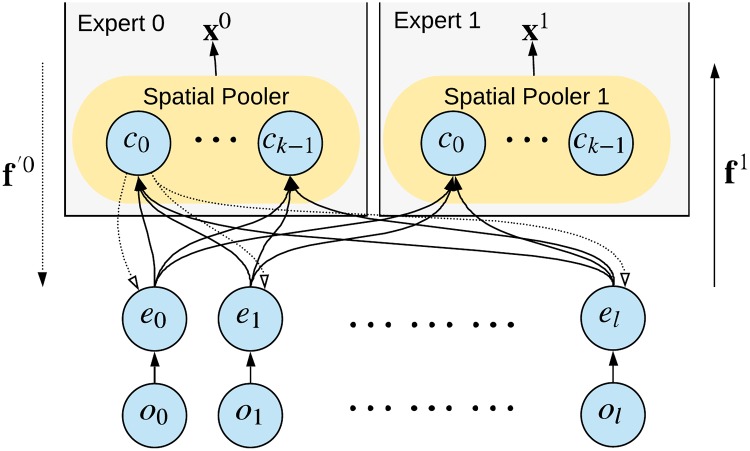
Illustration of the predictive group comparable to predictive coding algorithms.The Experts operate as usual (learning, inference), the forward/backward pass is just called iteratively for each observation.